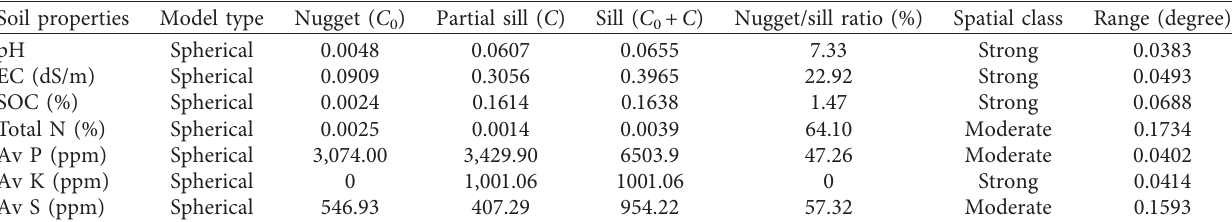
Table 3: Semivariogram model parameters for soil nutrients at the depth of